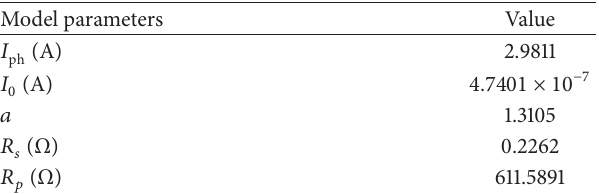
Table 2: Extracted the model parameters of the solar panel in standard